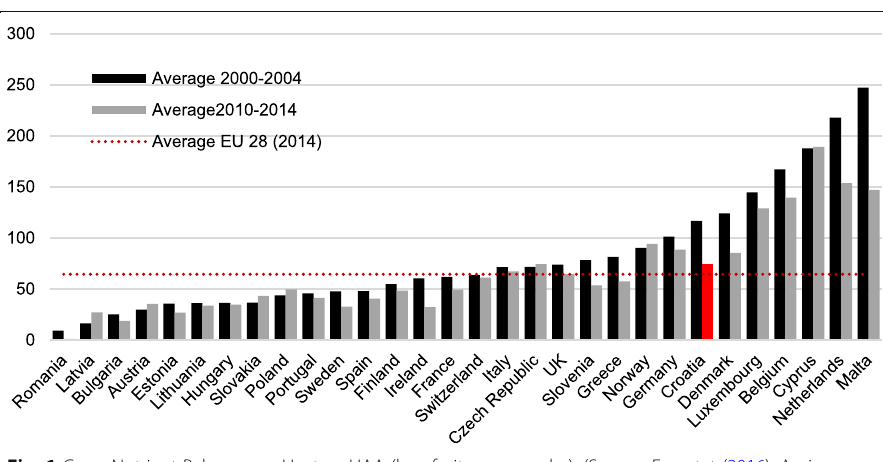
Fig. 1 Gross Nutrient Balance per Hectare UAA (kg of nitrogen per ha). (Source: Eurostat (2016). Agri- environmental indicators, Pressures and risks - Gross Nutrient